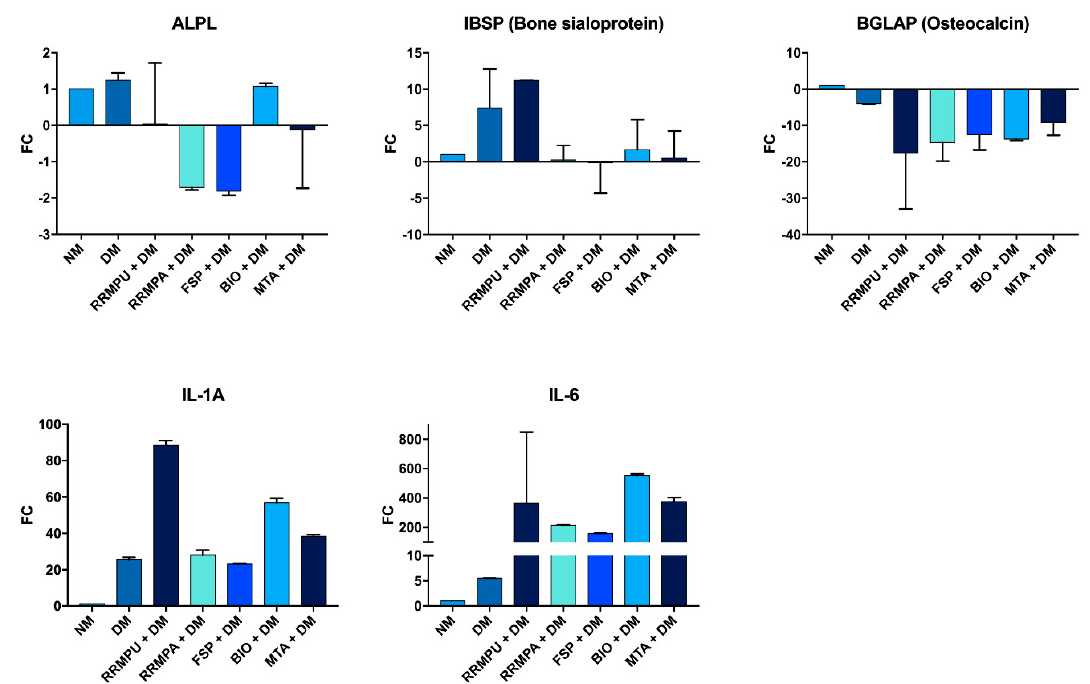
Figure 4. Evaluation of gene expression by RT-qPCR. The osteogenic di ff erentiation process was monitored by RT-qPCR: gene expression of alkaline phosphatase ( ALPL) , bone sialoprotein ( IBSP ), osteocalcin ( BGLAP ), interleukin 1 alpha ( IL-1a ) and interleukin 6 ( IL-6 ) was investigated. ALPL expression was significantly downregulated in all the conditions tested (top, left). IBSP expression was increased in culture with RRMPU, but the di ff erences were not statistically significant (top, middle). BGLAP expression was downregulated in all the conditions tested, without any statistically significant di ff erence (top, right). Upregulation of IL-1A (bottom, left) and IL-6 was detected in all the conditions tested (bottom, right).